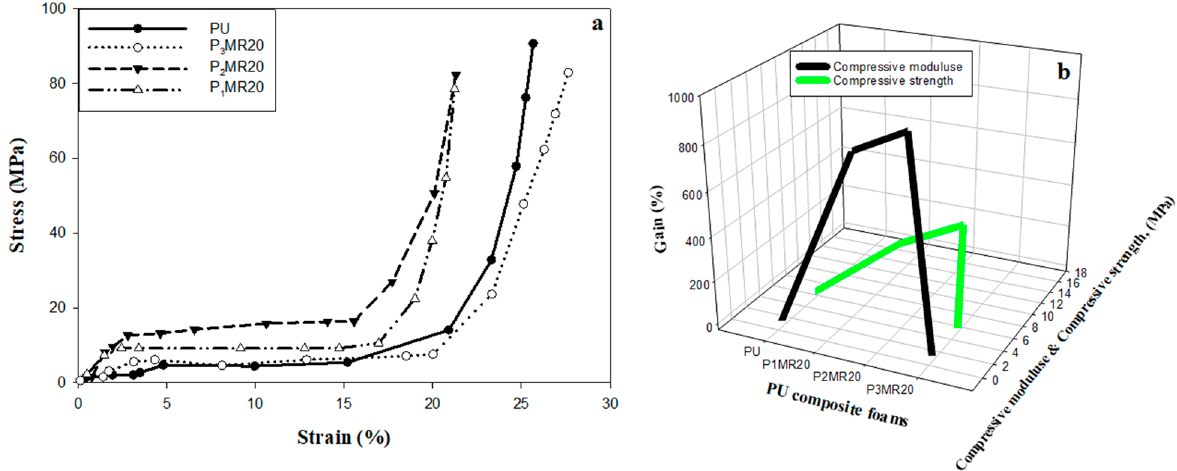
Figure 10. ( a ) Stress–strain curves for PU, P 1 MR20, P 2 MR20, and P 3 MR20. ( b ) Compressive test re- sults for the PU composite foams. results for the PU composite